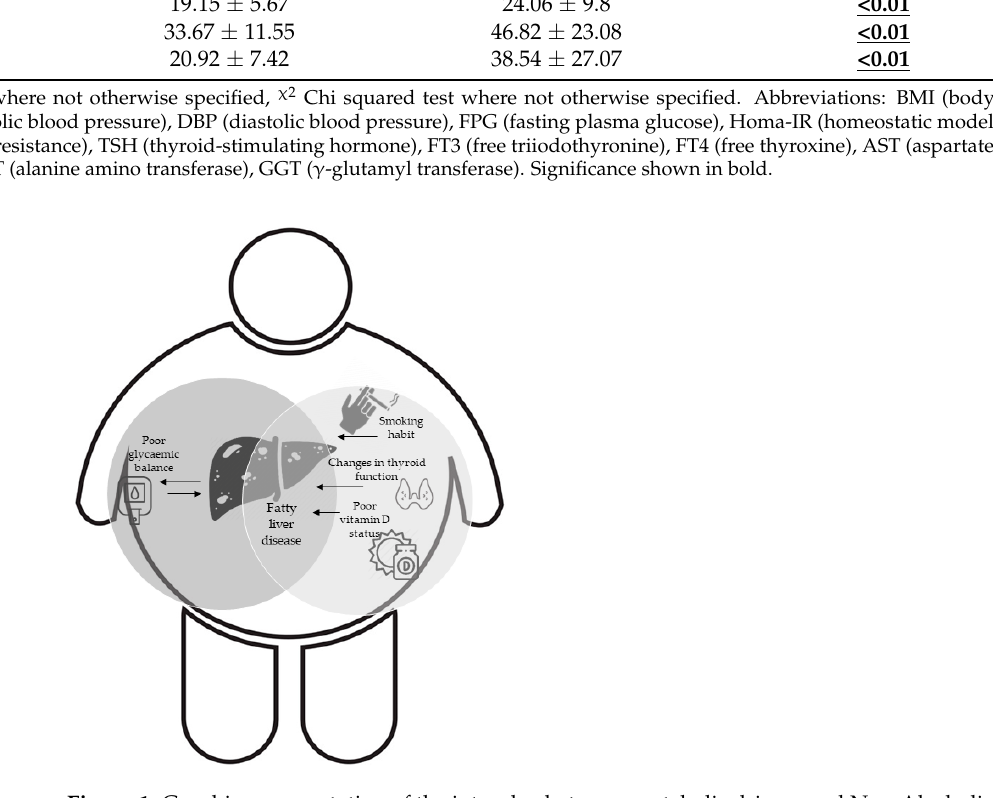
Figure 1. Graphic representation of the interplay between metabolic drivers and Non-Alcoholic Fatty Liver Disease (NAFLD) in obesity. Table 3. Logistic regression model of a high risk of NAFLD according to the FLI score.